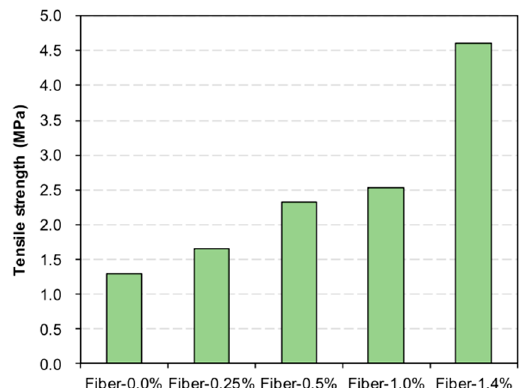
Figure 14. Tensile strength of specimens with various fiber ratios. Reprinted with permission from ref. [73]. Copyright 2020 Elsevier Ltd.